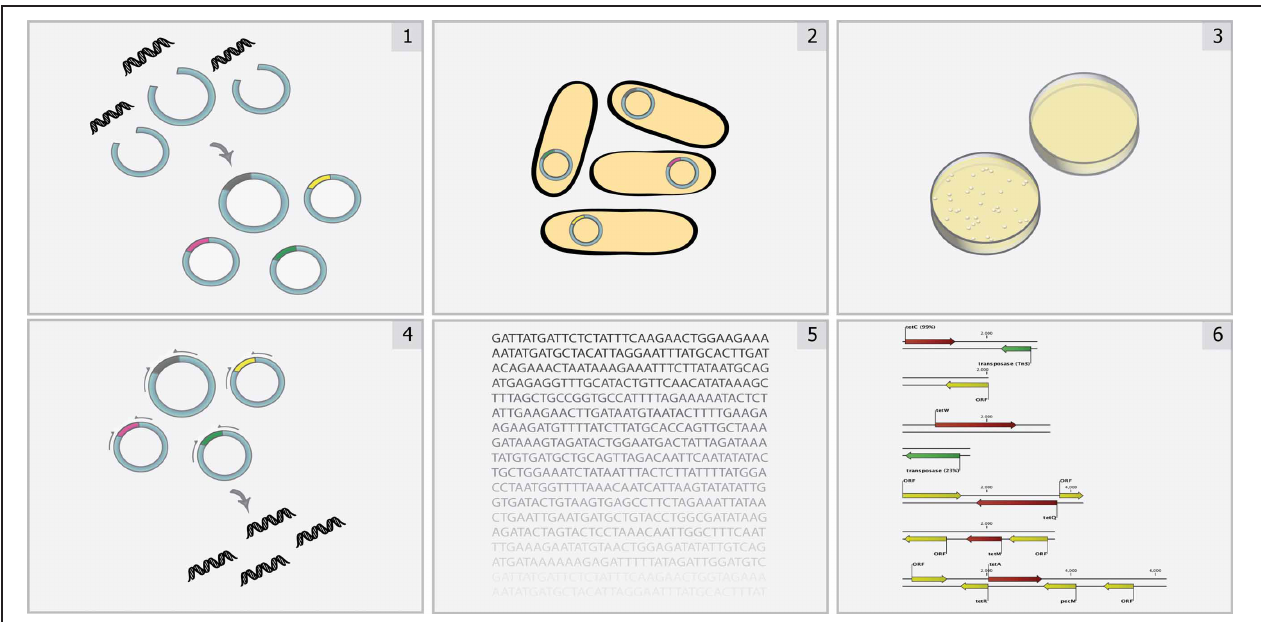
metagenomic fragments conferring antibiotic resistance. Metagenomic fragments present in colonies growing on antibiotic selection media are then PCR-amplified (Step 4) and sequenced using either traditional Sanger sequencing or next-generation sequencing methods (Step 5). Finally, reads are assembled and annotated in order to identify the causative antibiotic resistance genes (Step